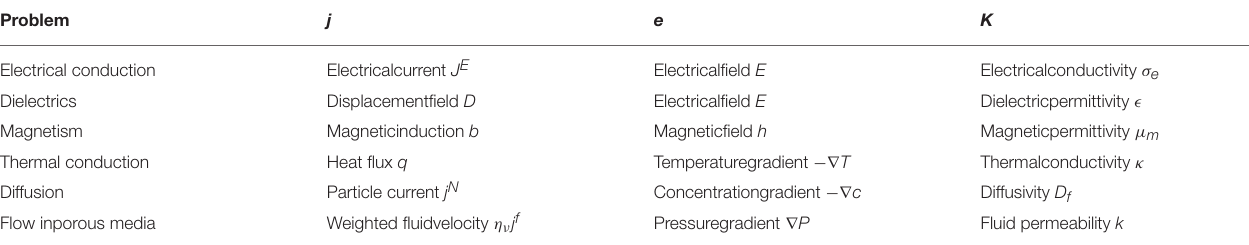
TABLE 1 | Interpretation of conductivity/dielectric-related equations under a steady state, as governed by a single class of PDE. Problem j e